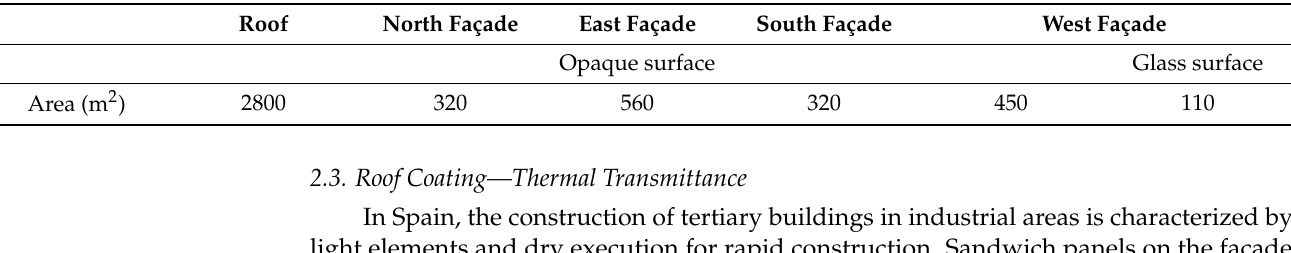
Table 1. Summary of areas per façade and roof.